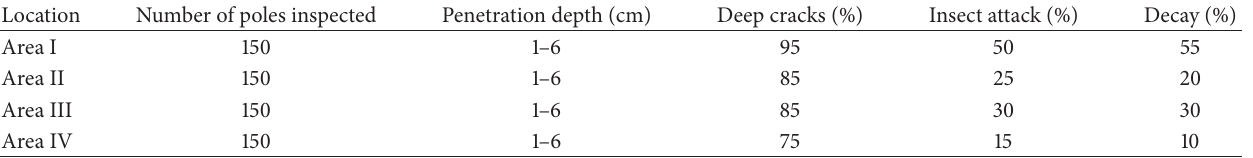
Table 1: Visual inspection of the utility poles in four different study areas in Artvin